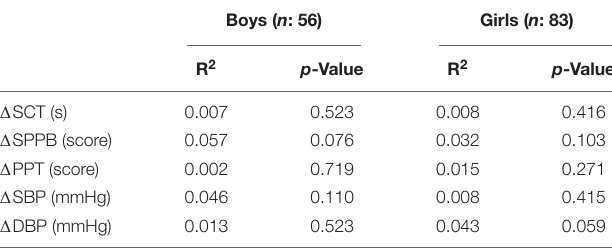
TABLE 2 | Linear regression between changes in Fat Mass ( (cid:49) FM) (kg) in adolescents with obesity and possible predictors. Boys ( n : 56)